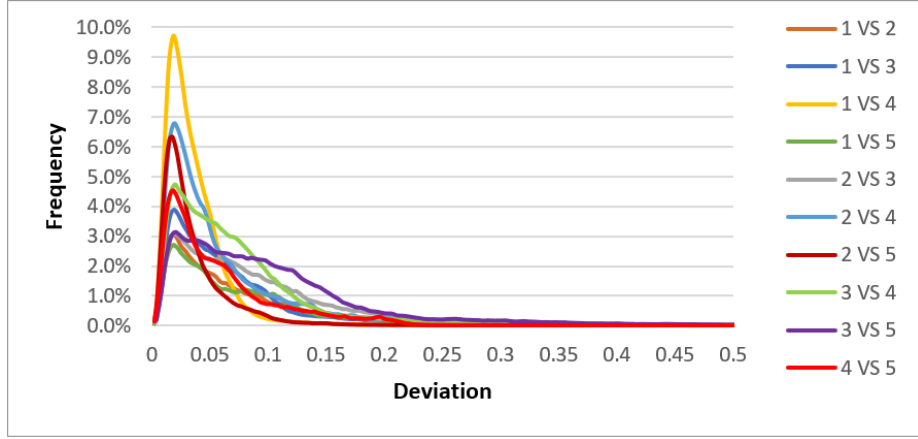
Figure 4. Deviation distribution as frequency: interscan comparison (scan number vs. scan number). Table 1. Percentage of points below determined deviation regions with highest divergence in terms of precision.